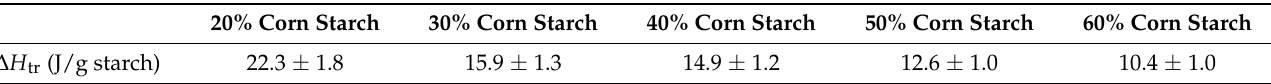
Figure 1. DSC thermograms of aqueous suspensions with different corn starch contents. The sets of experiments were performed by increasing starch concentration from 20% to 60% ( w / w ). The lines represent averages of three independent experiments ( n = 3) and the line thickness corresponds to SD. Table 2. Thermodynamic profile ( ∆ H tr ) of thermally induced transitions of starch suspensions with different corn starch